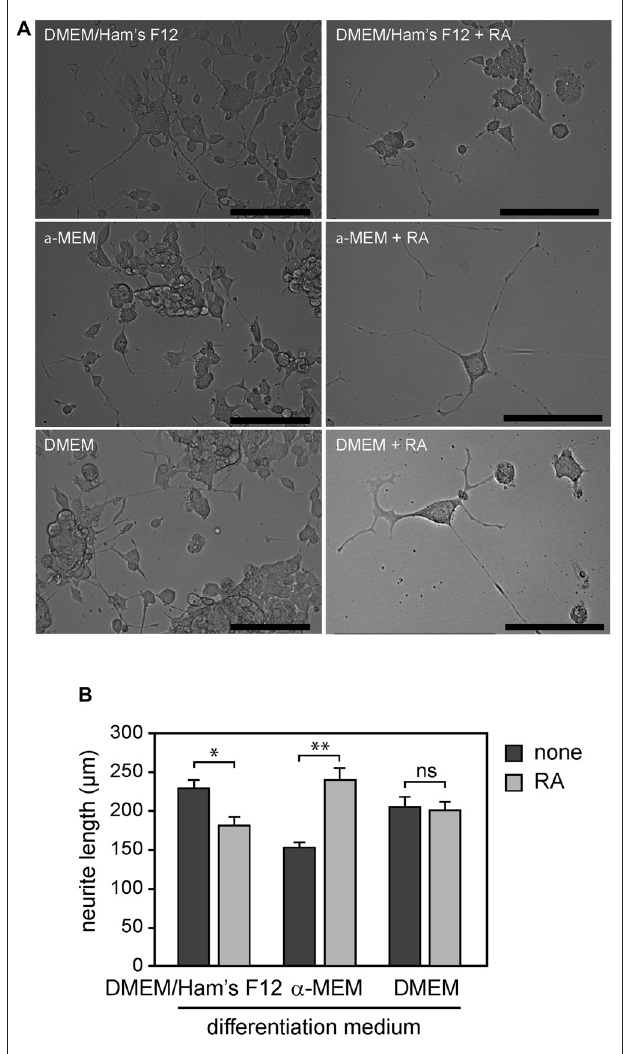
FIGURE 1 | (A) NSC-34 cells grown for 4 weeks in differentiation media with or without addition of all-trans retinoic acid (RA): DMEM/Ham’s F12, α -MEM and DMEM. (B) Morphological differentiation of NSC-34 cells determined by measurement of neurite length. Statistically significant difference from differentiated cells without addition of RA was defined using Mann-Whitney test, according to the different media: DMEM/Ham’s F12, α -MEM and DMEM. Values are means ± SEM (10–11 cells per experiment and four experiments for each condition), ∗ p < 0.001, ∗∗ p < 0.0001, ns = not significant, Mann-Whitney test + RA vs.